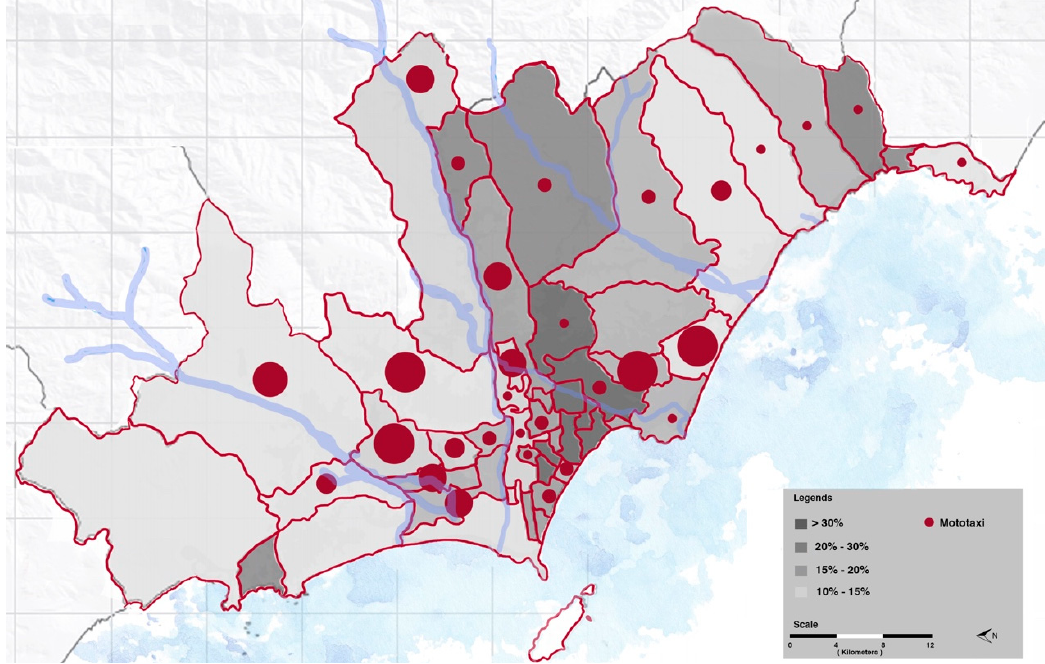
Figure 12. Comparison between car and mototaxi ownership in Lima. Source: References [13,39]. Map by authors.